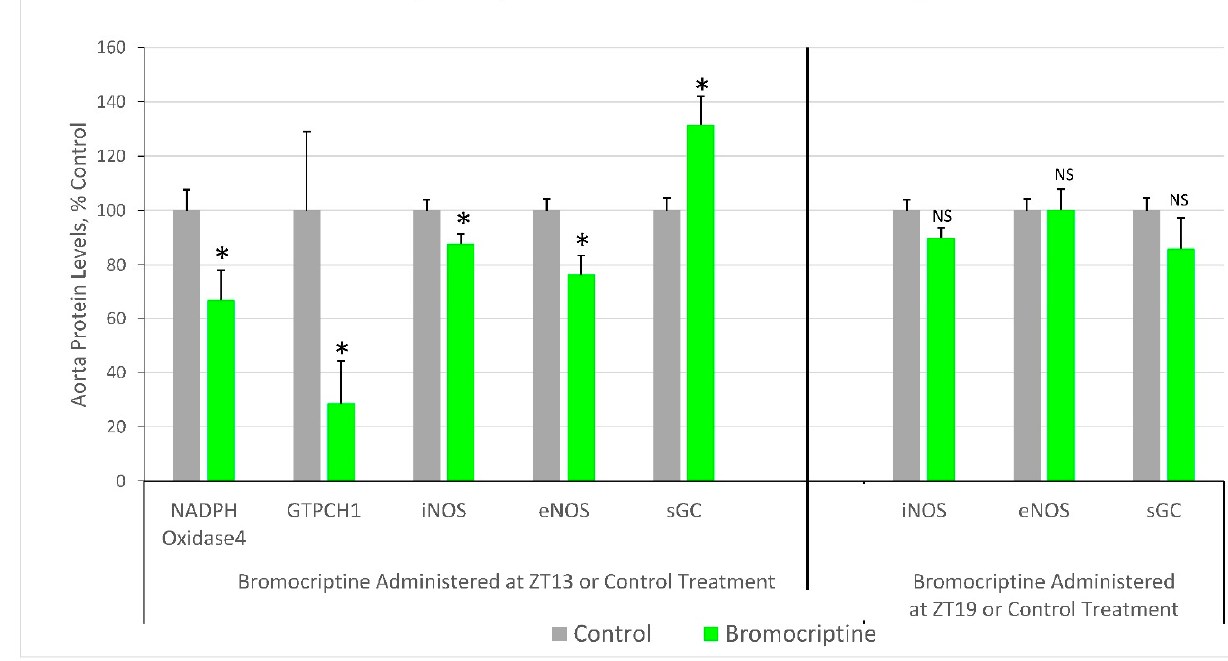
Figure 1. Impact of timed daily bromocriptine (at ZT 13 or ZT 19) or control treatment for 16 days on markers of vascular pathology. *— p < 0.05, 2-sided t -test; NS—not significant.